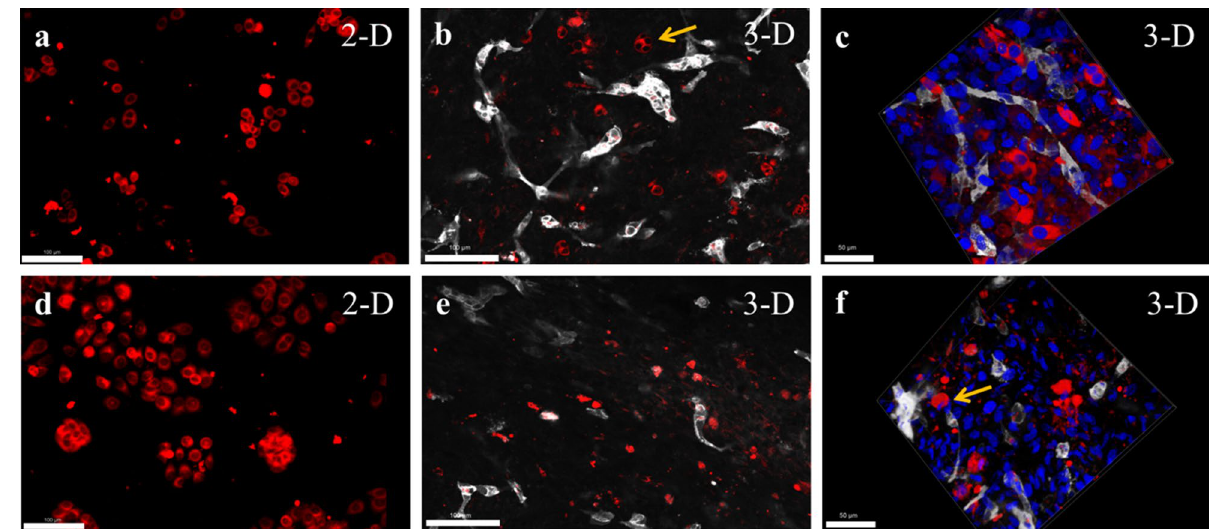
Figure 2. Formation of vascularized 3-D models with different breast cancer cell types. ( a ) Morphology of non-triple negative MCF-7 BCCs (red) in 2-D cell culture plate, Scale = 100 µm, ( b ) morphology of MCF-7 BCCs embedded in scaffold-free vascularized tissue, vessels were stained (grey) with PECAM1 (CD-31), arrow indicates grouping of MCF-7 cells that forms tumor clusters, Scale = 100 µm, ( c ) 3-D z-stacked image of MCF-7 within a vascularized tissue highlights its morphology, Scale = 50 µm, ( d ) morphology of triple-negative MDA-MB468 (red in 2-D culture, Scale = 100 µm, ( e ) MDA-MB468 display isolated and rounded morphology within scaffold-free vascularized models, ( f ) 3-D z-stacked image of MDA-MB468 and the vascularized 3-D tissue, arrow highlights the rounded morphology within the vascularized model, Scale = 50